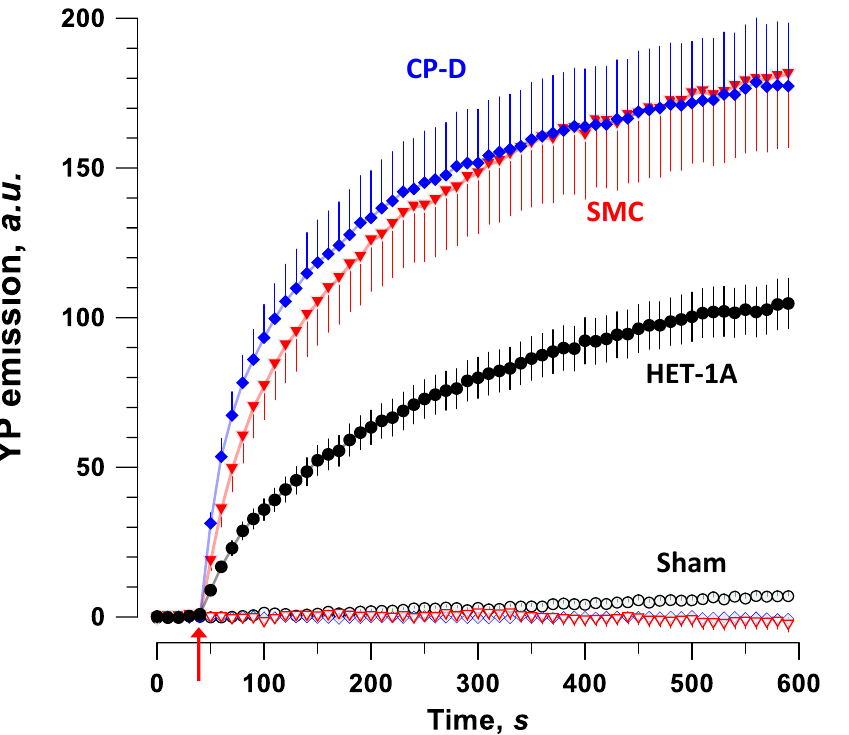
Figure 3. Electroporation of pre-malignant epithelium (CP-D), normal epithelium (HET-1A), and smooth muscle cells (SMC) measured by YP uptake after ten, 300-ns, 10 kV/cm pulses applied at 5 Hz (arrow). Spindle-shaped SMC were aligned perpendicular to the electric field; irregular-shaped epithelial cells were not oriented in the field. SMC and CP-D cells showed similar YP uptake throughout the 10-min recording. YP uptake in HET-1A was significantly lower, indicating a higher resistivity to permeabilization with electric pulses. Sham-exposed cells (open symbols) showed no YP uptake. Mean ± SEM, n = 19 – 40.